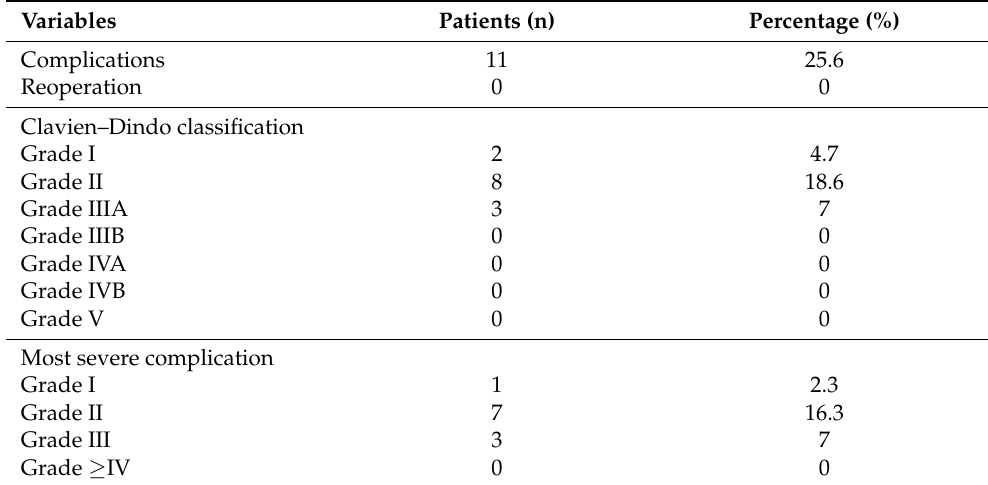
Table 2. Evaluation of postoperative complications according to the Clavien–Dindo